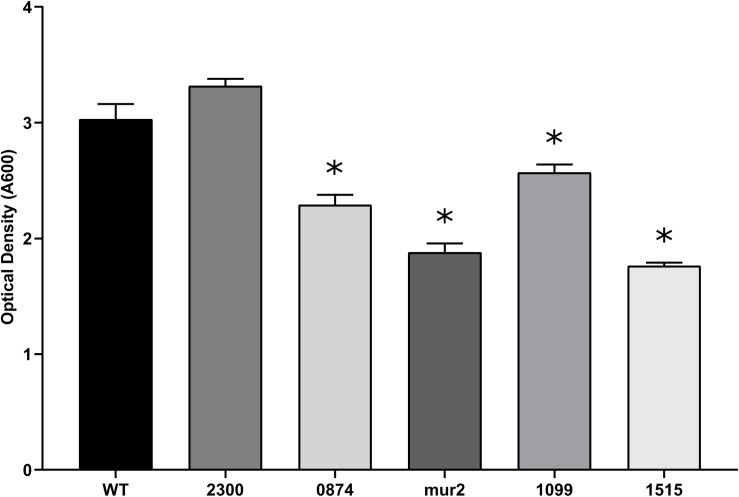
Putative virulence factors of S. sanguinis are associated with a reduction in biofilm production. Biofilm production of the indicated strains after 24 h of anaerobic growth in BM containing 1% sucrose. Inoculums of each strain were normalized after overnight growth in BHI. All strains exhibited growth in BM indistinguishable from WT (Supplementary Figure S1). Adherent biomass was quantified by retention of crystal violet and measuring the optical density after solubilization at an absorbance of 590 nm. Assays were performed in quadruplicate and three experiments were performed. Statistical analysis was performed using one-way ANOVA and corrected for multiple comparisons against the WT mean using Dunnett’s test. ∗p < 0.05. Error bars represent the standard error.